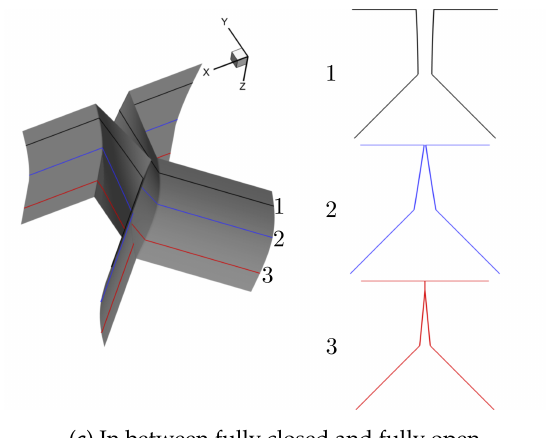
Figure 4. Representative divergent shape (For each representative shape, three planar surfaces in the x − y plane are extracted along the anterior-posterior ( z ) direction to give a detailed view of the glottis shape and the number of each planar surface is denoted as 1, 2, 3 from the anterior to the posterior direction,